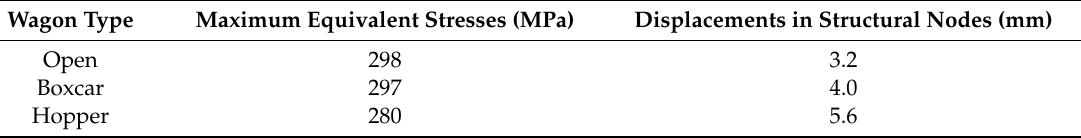
Table 2. Basic strength parameters of the carrying structures of articulated circular-tube wagons.